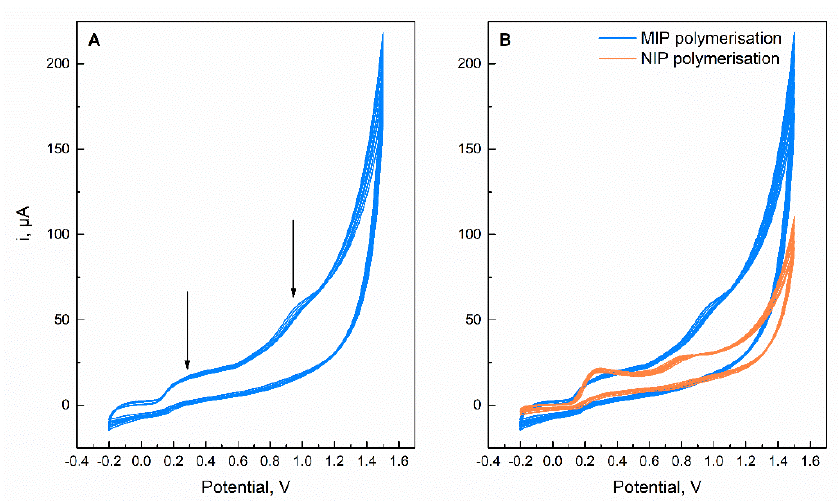
Figure 3. ( A ) Cyclic voltammograms of the MIP SPCE modification with 1.5 mmol L − 1 ABA and 0.5 mmol L − 1 ATV in buffer solution and ( B ) comparison of cyclic voltammograms building in MIP and NIP sensors.